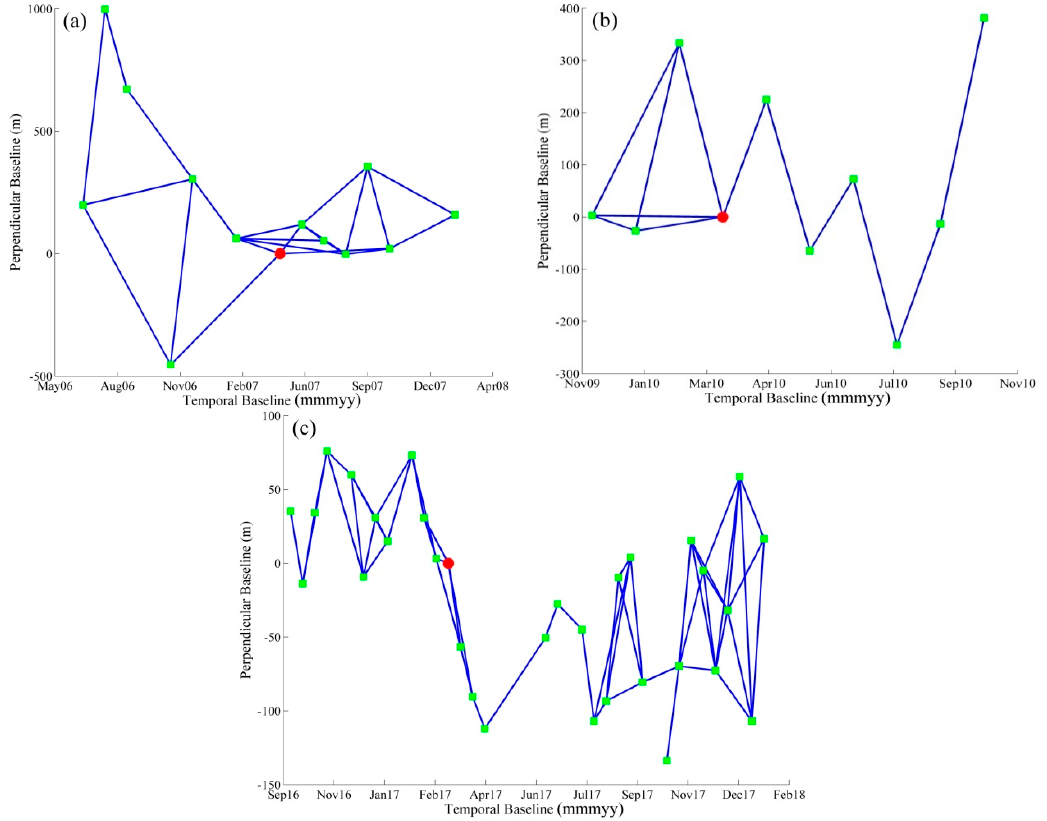
Figure 2. Spatiotemporal baseline map of interferometric pairs of three image sets. The red dot denotes the master images, the green square denotes the slave images. ( a ) Interferometric pairs of ENVISAT data (track: 361, frame: 2925); ( b ) interferometric pairs of ENVISAT data (track: 404, frame: 2907); ( c ) interferometric pairs of Sentinel-1A.